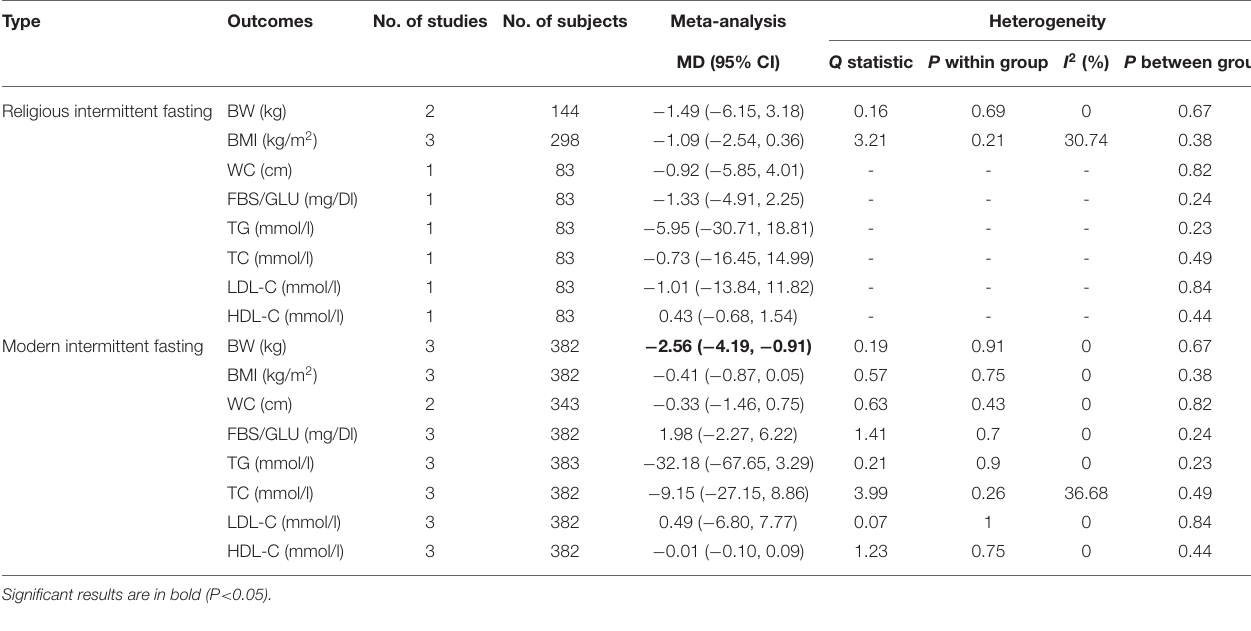
TABLE 2 | Subgroup analyses of the effects of intermittent fasting on a fasting regimen.